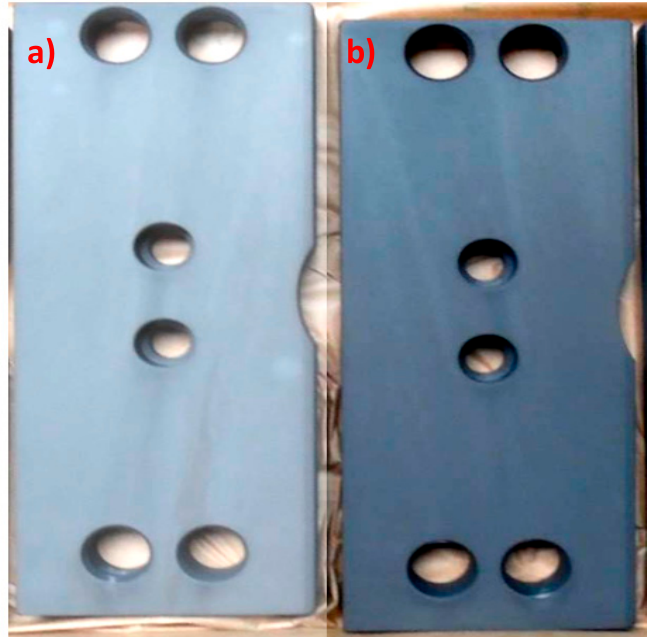
Figure 8. View of the sample covered with a manganese phosphate coating with calcium ( a ) and view of the sample covered with manganese phosphate without calcium ( b ). The samples were produced under the same